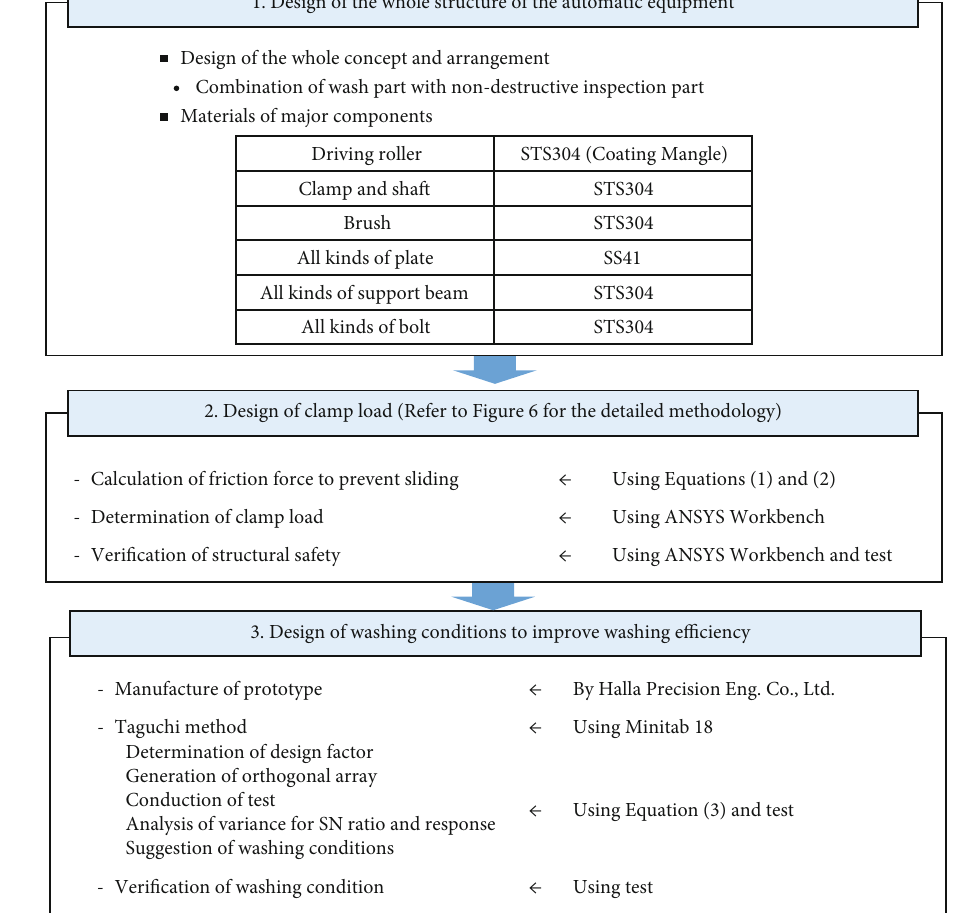
Figure 2: Methodology for the development of the automatic machine.